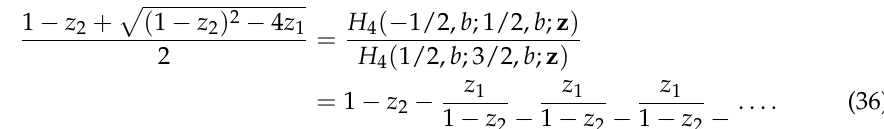
Figure 3. The plots where the approximant f 20 ( z ) of BCF (33) guarantees certain truncation error bounds for function arctan ( 2